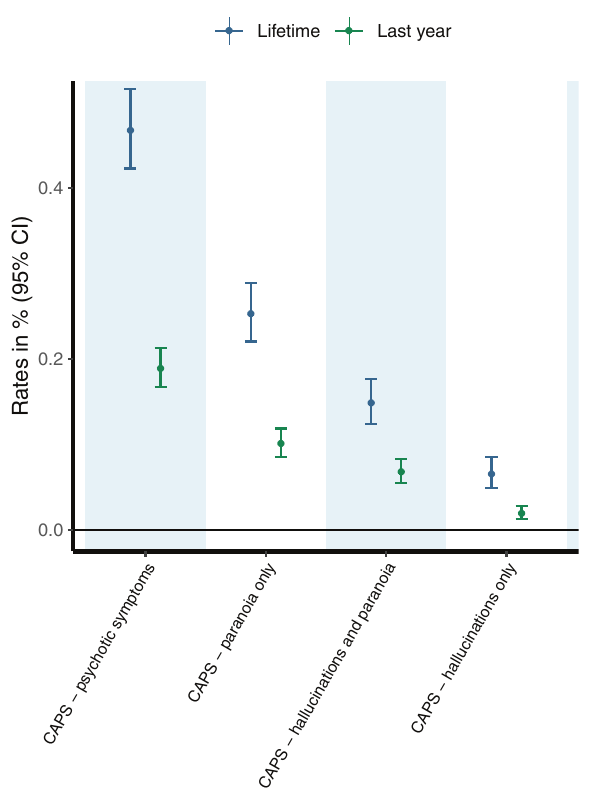
Fig. 1 Rates of lifetime and last year cannabis-associated psychotic symptoms (CAPS) requiring emergency medical treat- ment. Estimated are rates of cannabis-associated psychotic symptoms (CAPS) resulting in emergency medical treatment in people who use cannabis (PWUC). Rates are plotted separately for lifetime risk of CAPS ( n = 85,366, displayed in blue) and last year risk of CAPS ( n = 148,109, displayed in green). The legend refers to the different symptom pro fi les of CAPS leading to emergency medical treatment, including the occurrence of either hallucinations or paranoia ( “ CAPS — psychotic symptoms ” ), hallucinations and para- noia ( “ CAPS — hallucinations and paranoia ” ), only paranoia but no hallucinations ( “ CAPS — paranoia only ” ), or only hallucinations but no paranoia ( “ CAPS — hallucinations only ” ). The proportion of PWUC reporting to have sought emergency medical treatment following cannabis use (not limited to psychotic symptoms only) included 1.11% (1.04; 1.19) and 0.59 (0.55; 0.63) in the lifetime and in the last year, respectively. All corresponding estimates are provided in Supplementary Table